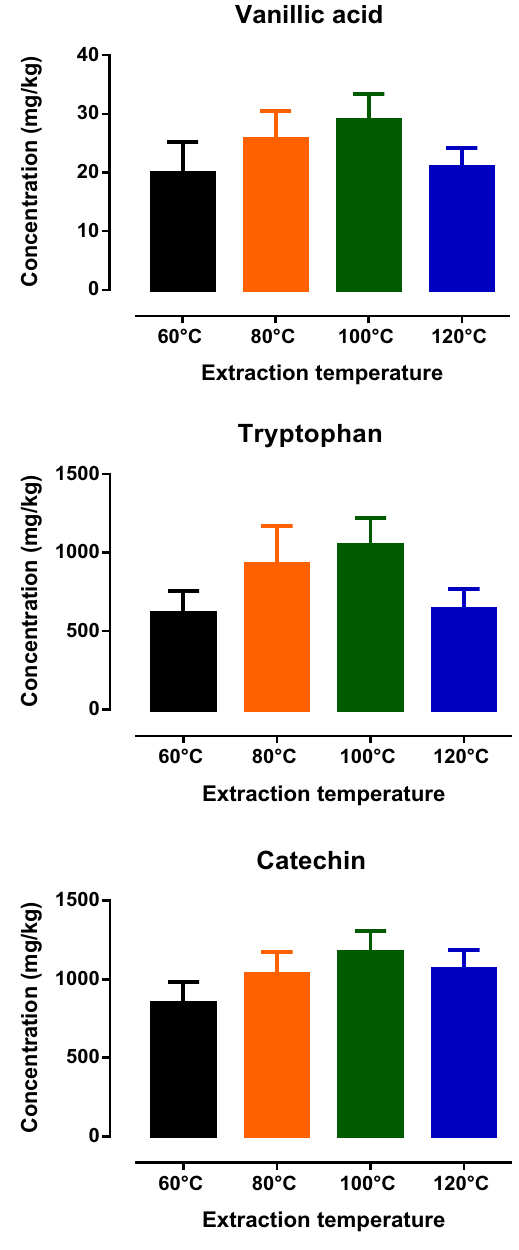
Figure 1. Amount of vanillic acid, tryptophan and catechin (mg/kg) detected in avocado seed extracts from PHWE at 60 °C, 80 °C, 100 °C and 120 °C with LC/UV by external standard calibration (n =